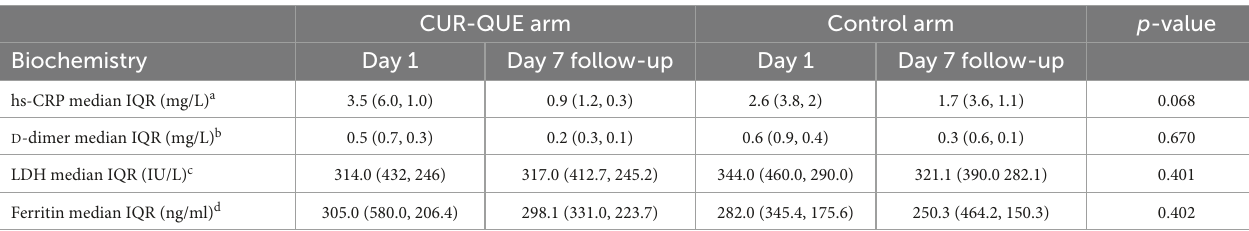
TABLE 2 Patients’ laboratory biochemistry at day 1 and follow-up day 7 in the two treatment groups.